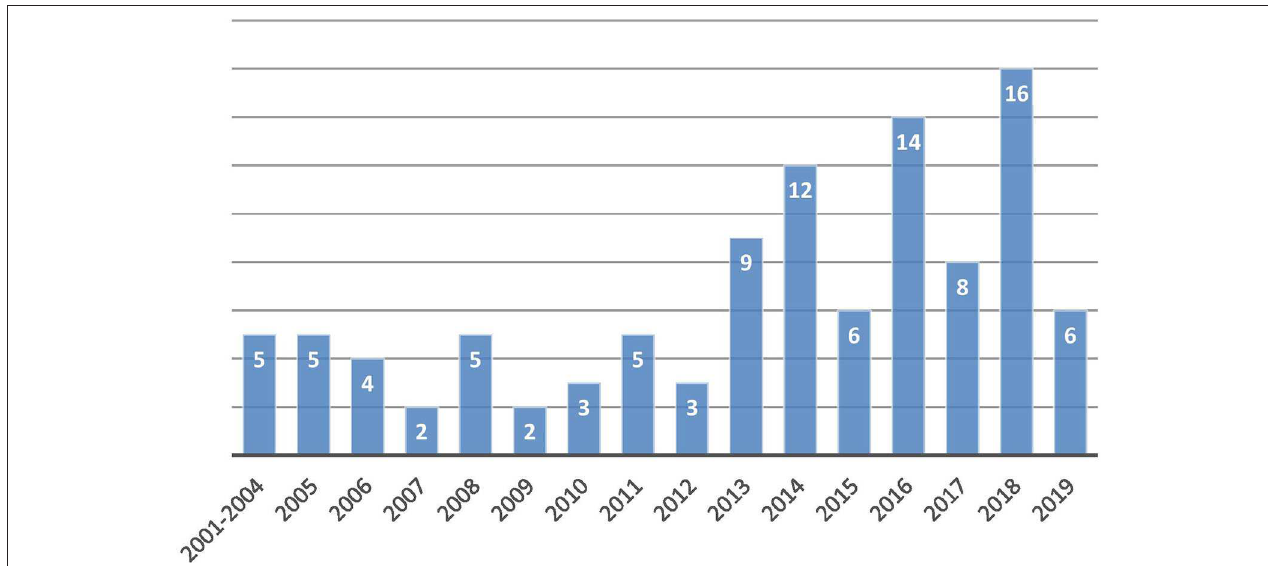
FIGURE 1 | Number of new patients per year.